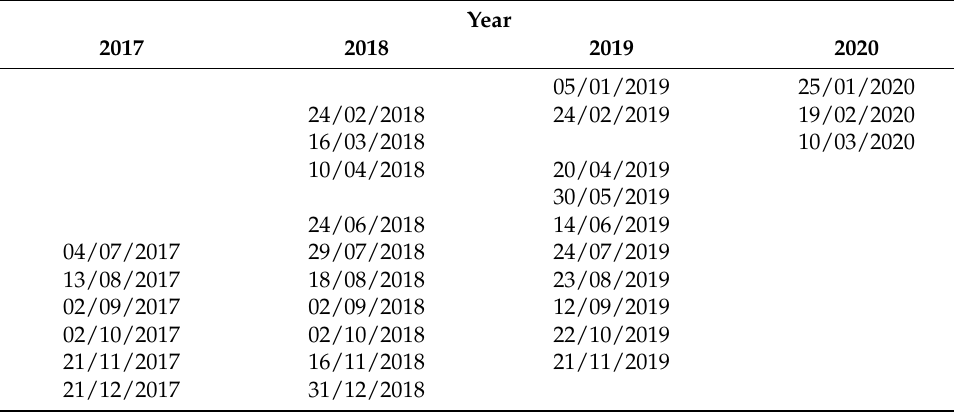
Table 2. Dates of acquisition of bathymetries.